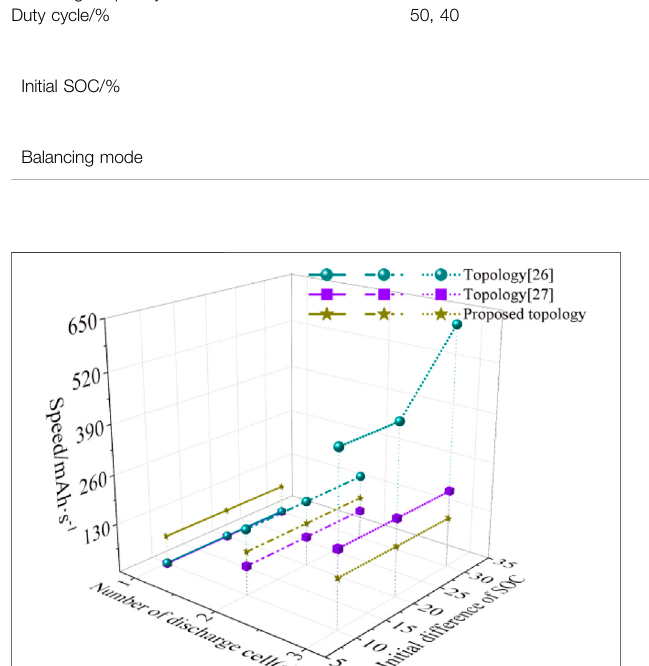
FIGURE 6 | Balancing speed comparison.